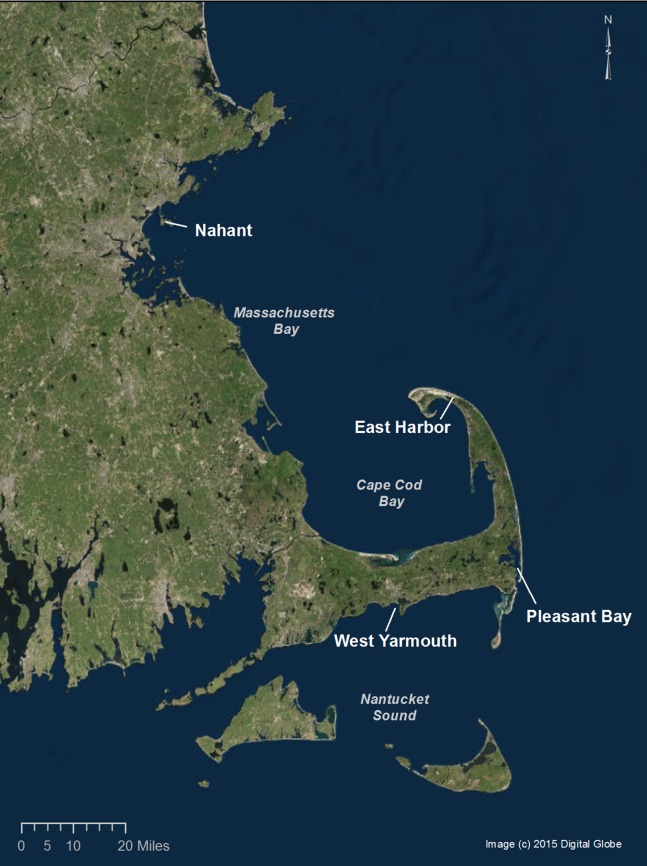
Location of the source and transplant sites.Note: East Harbor and Pleasant Bay served as source and transplant sites. Distances between sites are denoted in Table S2. Source: 2015 DigitalGlobe.